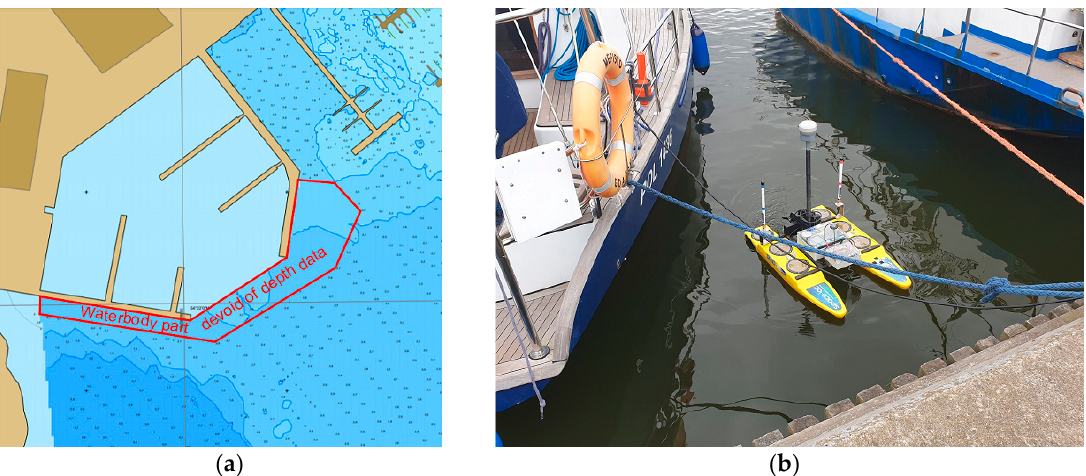
Figure 8. The waterbody in which no surveys were conducted in an automatic mode, due to the yachts moored there ( a ). A depth measurement between the moored yachts—direct control ( b ). Bathymetric measurements with the use of the USV lasted 3 h 15 min, during which 11,687 points were recorded at a frequency of 1 Hz. At this time, the USV traveled 4.743 km with an average speed of 1.46